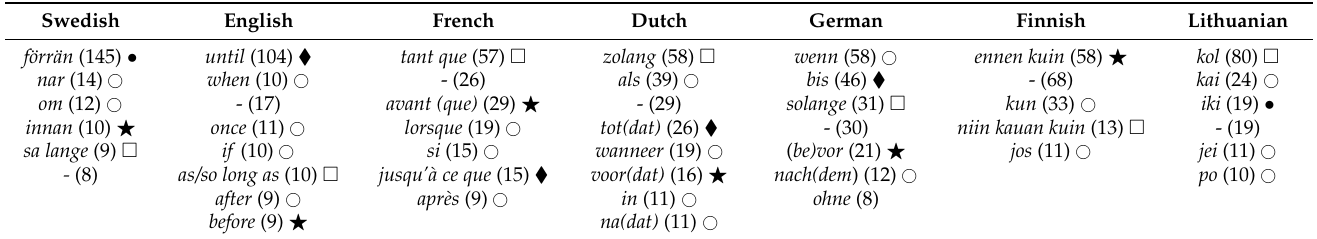
Table 4. Data with category indication.